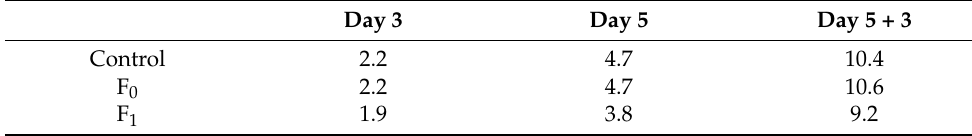
Table 6. Weight loss (%) per treatments/each analysis date.